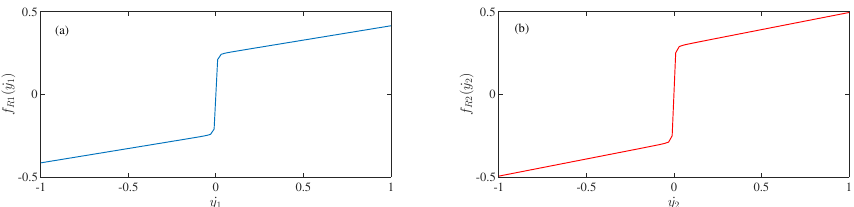
Figure 3. Plots of the resistance force terms f R1 ( ˙ y 1 ) and f R2 ( ˙ y 2 ) corresponding to the ( a ) state-variable ˙ y 1 and ( b ) state-variable ˙ y 2 , respectively. In each figure, the x -axis is the non-dimensional velocities (i.e., state-variables ˙ y 1 and ˙ y 2 ) and the y -axis is the non-dimensional force due to the resistance term. The parameter values are: a 1 = 5.8548 × 10 − 3 , ( a ) ζ 1 = 0.0868, ( b ) ζ 2 = 0.1036. (Color